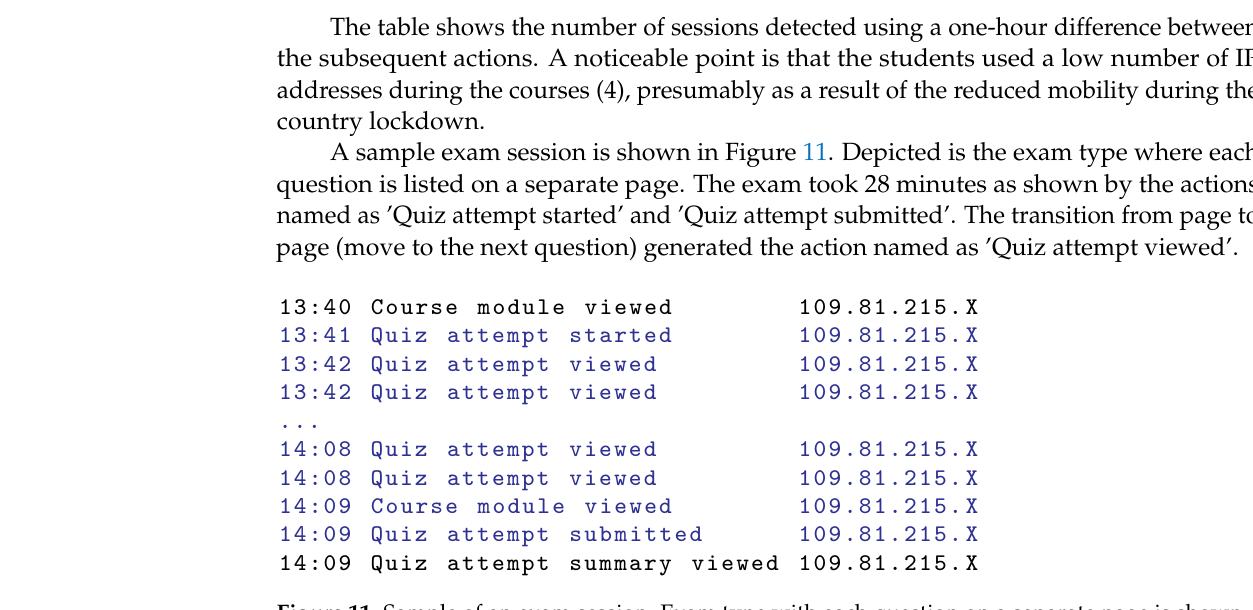
Figure 11. Sample of an exam session. Exam type with each question on a separate page is